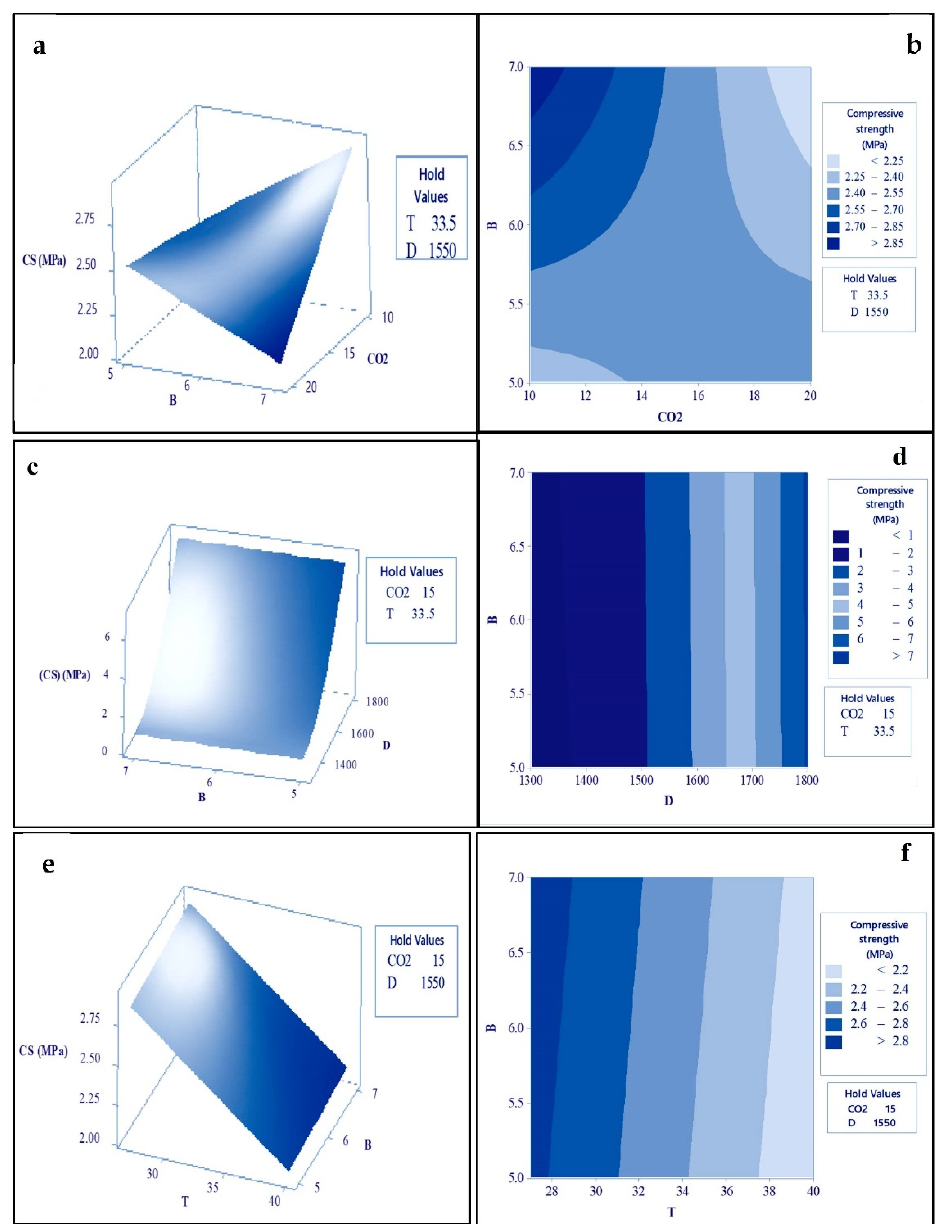
Figure 5. Response surface and contour plots for compressive strength of B-FCB; ( a , b ) between B and CO 2 , ( c , d ) between B and D and ( e , f ) between B and T.